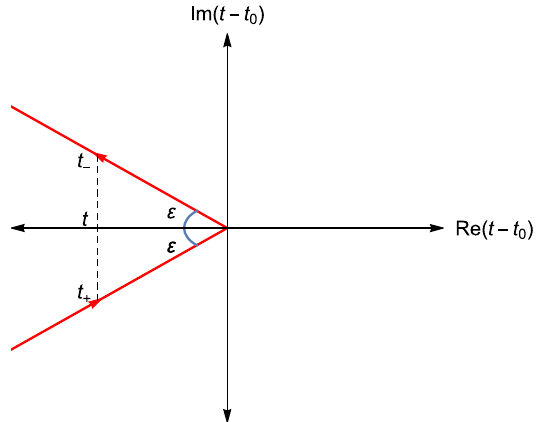
(b) T 2 : the natural complex time contour that is relevant in the ‘in-in’ formalism. Fig. 1 Different contours used for deriving the backreaction